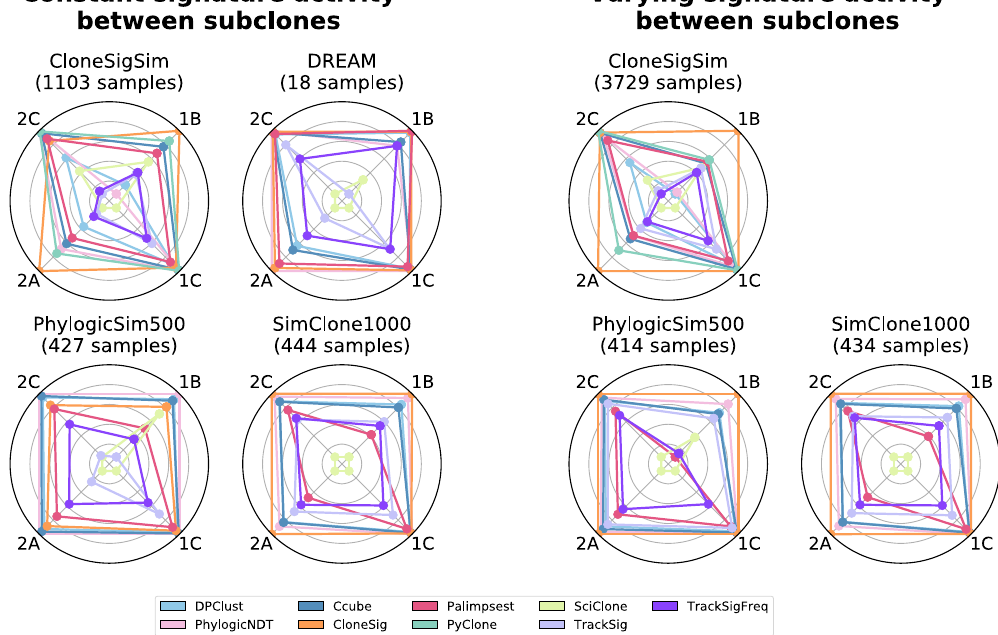
Fig. 2 Subclonal reconstruction performance of CloneSig and eight ITH reconstruction methods on simulated data. Each radar plot summarizes the performance of the nine ITH reconstruction methods according to four performance measures on one set of simulated data. In short, score1B evaluates the number of clones found by the method, score1C the resulting mutation CCF distribution, score2A the co-clustering of mutations in the de fi ned clones, and score2C the classi fi cation of subclonal versus clonal mutations. All scores are normalized such that the best performing method lies on the outer circle, and the worst near the center, to enhance visual distinction between methods. We have ensured that all scores are comparable by averaging them only on simulations where all methods successfully produced an estimate under reasonable computation time and memory limits; PyClone results are not shown on the DREAM, PhylogicSim500 and SimClone1000 datasets because it failed to produce an output too often. The four simulated sets on the left follow the “ constant ” scenario, where signature activities are the same across all subclones, while the three simulated sets on the right follow the “ varying ” scenario, where signature activities vary between subclones. Source data are provided as a Source Data fi